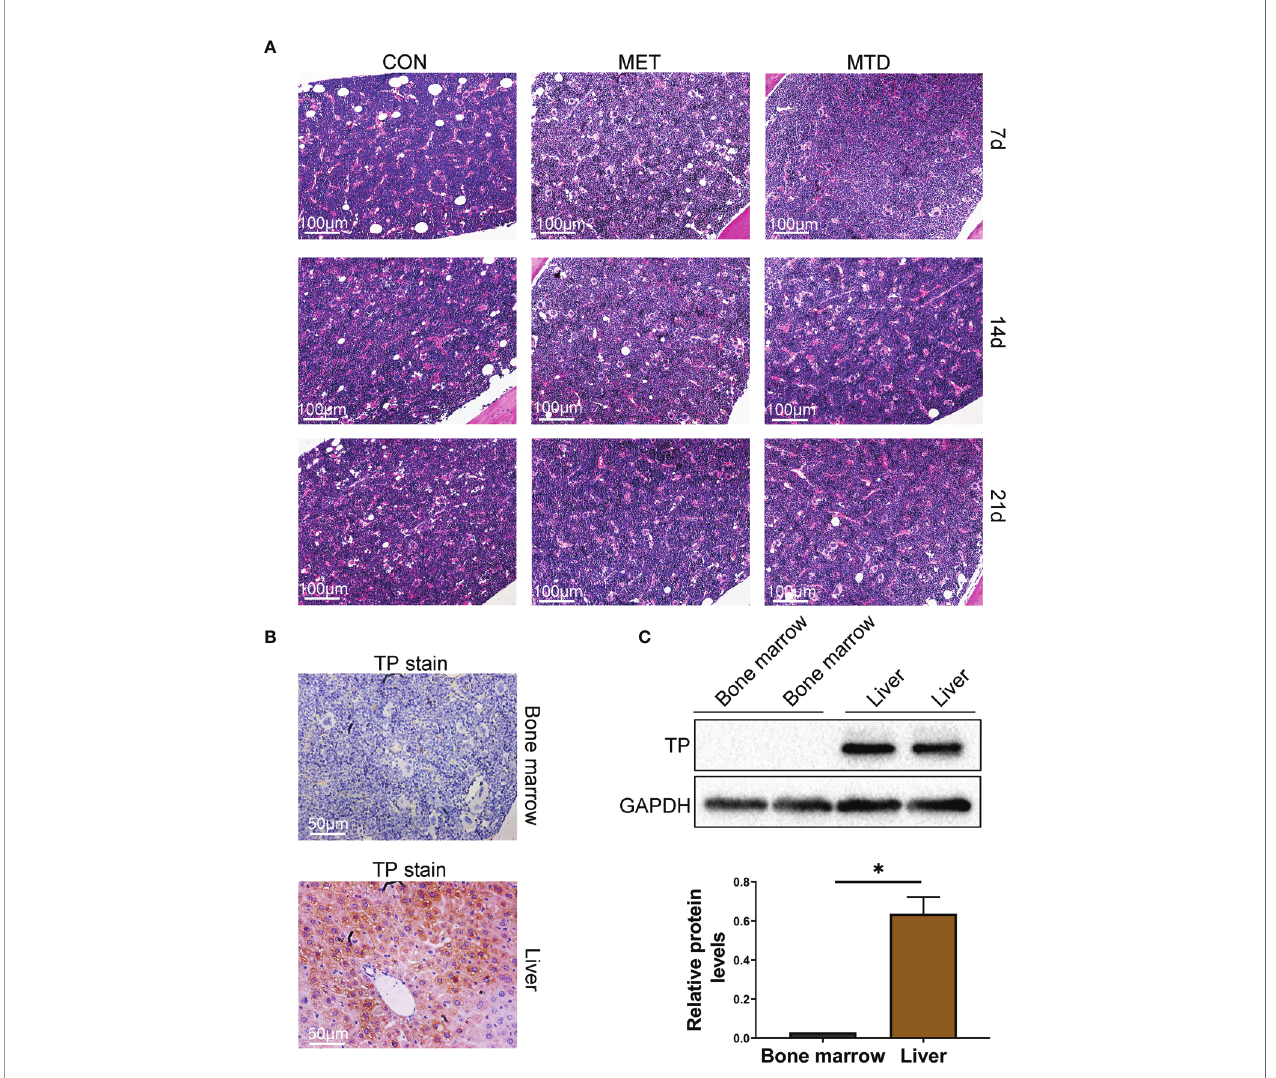
FIGURE 1 | Pathological changes and TP expression in bone marrow of mice. (A) Bone marrow tissue was stained with H&E (100×). CON: control groups, in which mice received 0.9% normal saline. MET: CAP-treated groups in which mice received metronomic chemotherapy dose of CAP (100 mg/kg/d). MTD: CAP-treated groups in which mice received maximum tolerated dose of CAP (400 mg/kg/d). (B) TP in bone marrow and liver was stained with IHC (200×). TP in liver served as a positive control. (C) Bone marrow cells were collected from the femora, protein levels of TP were evaluated using the western blot assay, and TP in the liver served as a positive control. Data are shown as mean ± SD. * P <